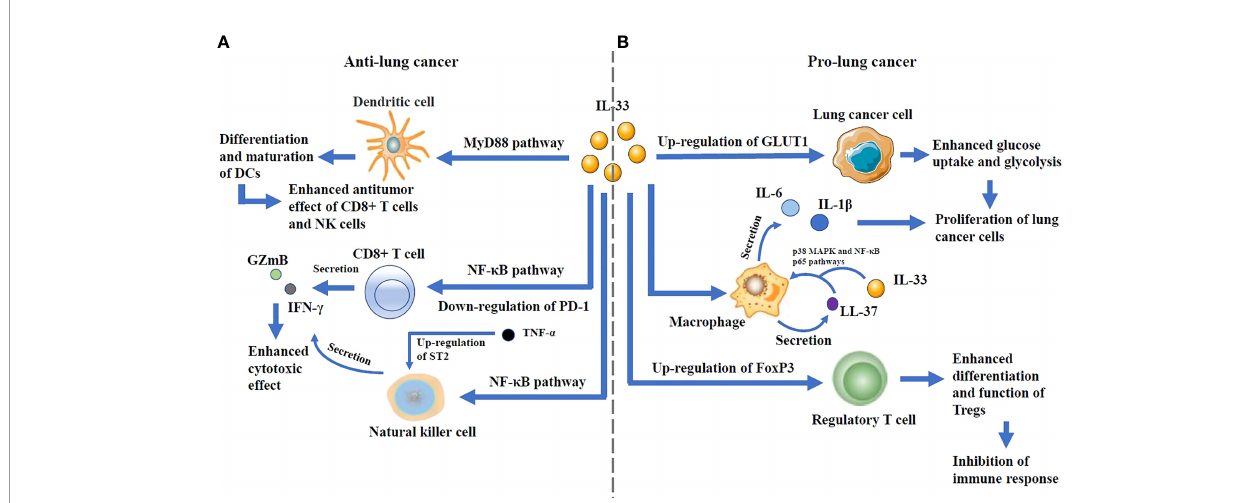
FIGURE 3 | (A) The anti-lung cancer effects: IL-33 can promote the differentiation and maturation of DCs through MyD88 pathway, thus increasing the antitumor effect of CD8+ T cells and NK cells. It is also able to enhance the secretion of GZmB and IFN- g by CD8+ T cells and NK cells through NF- k B pathway. Notably, IL-33 downregulates PD-1 expression in CD8+ T cells, and its interaction with TNF- a , which up-regulates ST2 expression in NK cells, enhances antitumor effects. (B) The pro-lung cancer effects: By up-regulating the expression of GLUT1 on lung cancer cells, IL-33 can enhance their glucose uptake and glycolysis, which lead to the proliferation of lung cancer cells. IL-33 increases the secretion of the antimicrobial peptide LL-37 in macrophages. LL-37 cooperates with IL-33 to increase the phosphorylation of p38 MAPK as well as NF-kB p65 pathways, and augment IL-6 and IL-1b secretion, thus resulting in the proliferation of lung cancer cells. IL-33 can increase the frequency of Tregs in tumor-in fi ltrating lymphocytes and enhance the differentiation and function of Tregs by up-regulating the expression of FoxP3, which can lead to immune